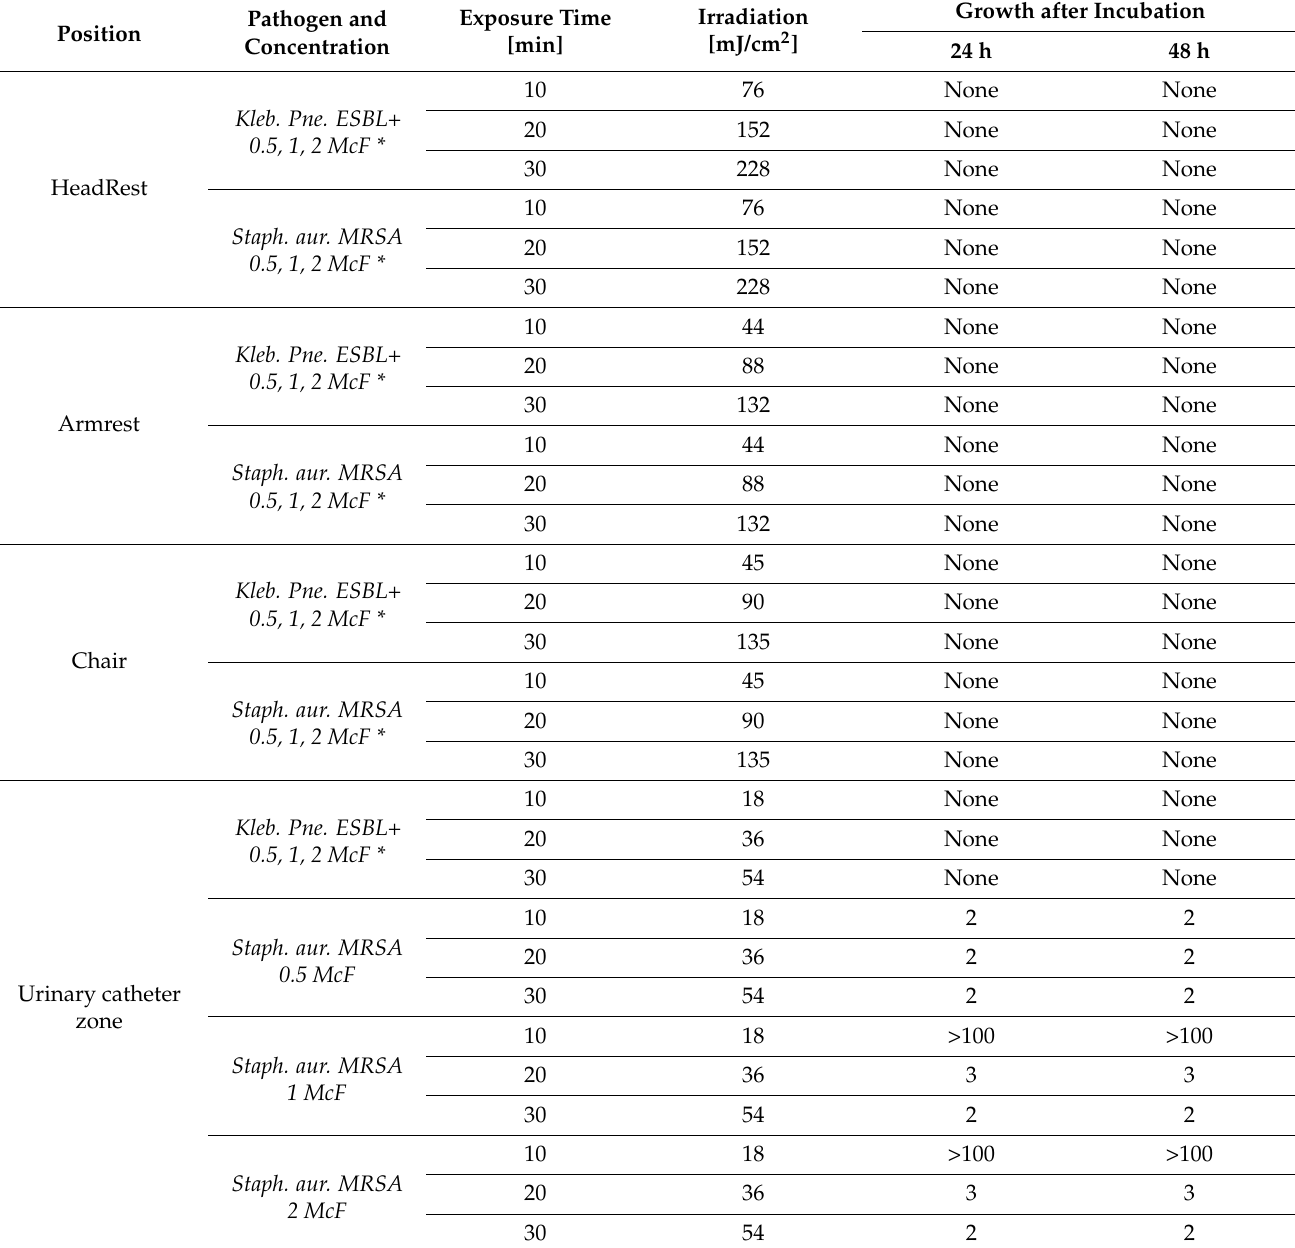
Table 3. Results of UVC susceptibility test on MDR bacteria performed in the